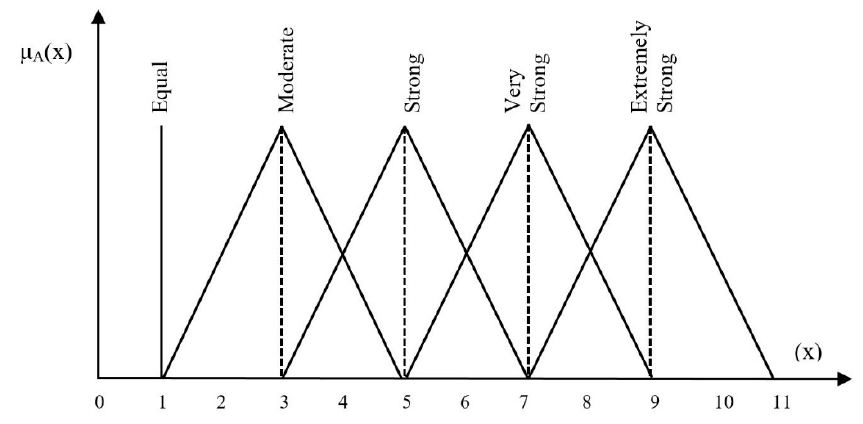
Figure 8. Linguistic scale triangular numbers for the relative importance.